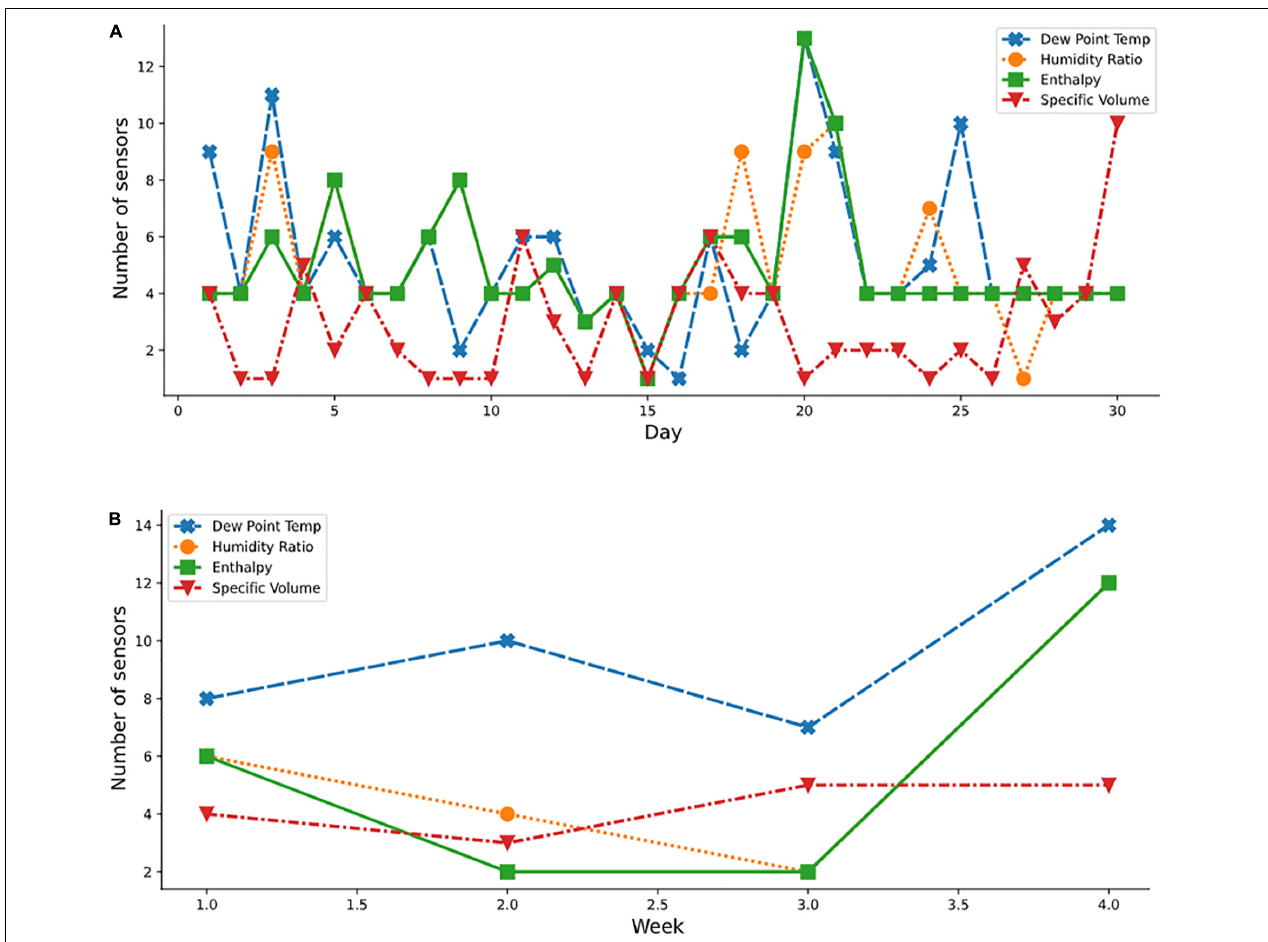
FIGURE 9 | Optimal sensor selection for spring month using the psychometric dataset; (A) April daily; and (B)